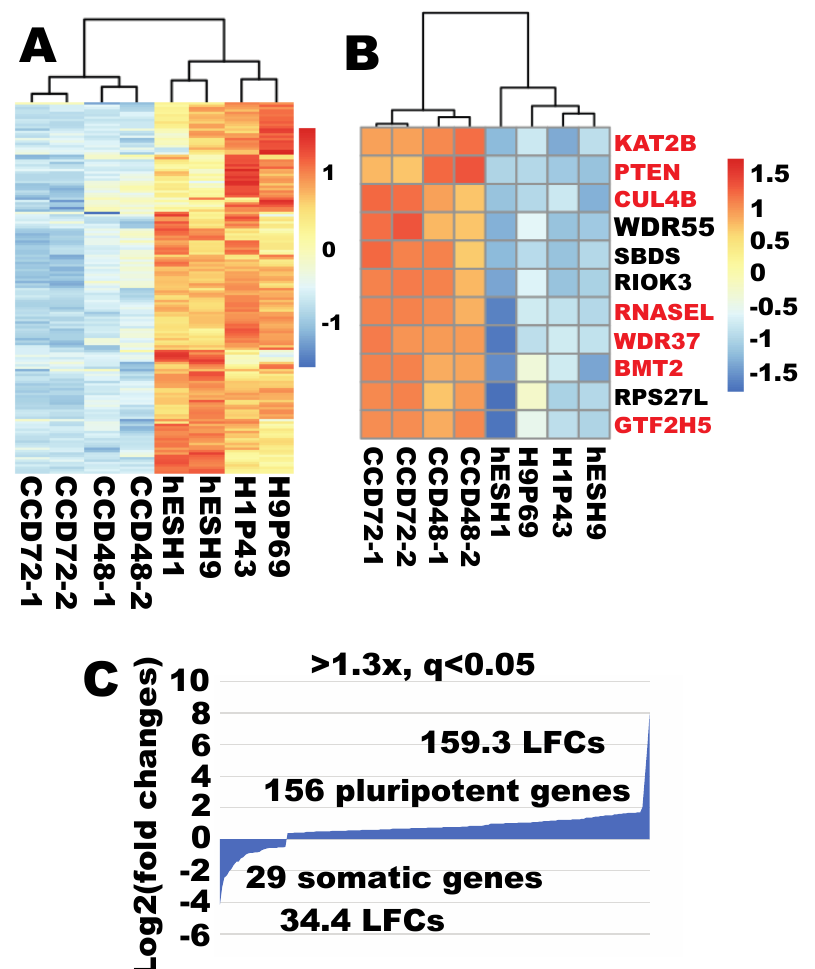
Figure 9. Ribosome biogenesis remained more robust in human ESCs compared with an independent fibroblast line. ( A ) Out of 298 RB genes, 156 were expressed significantly higher in ESCs (> 1.3×, q < 0.05). ( B ) Out of 298 RB genes, only 11 RB genes were expressed significantly higher in fibroblasts than in ESCs (> 2×, q < 0.01). ( C ) Quantification of expression enrichment of RB genes in ESCs relative to fibroblasts. H1P43 and hESH1 are human ESC line H1 at di ff erent passage numbers; H9P69 and hESH9 are human ESC line H9 at di ff erent passage